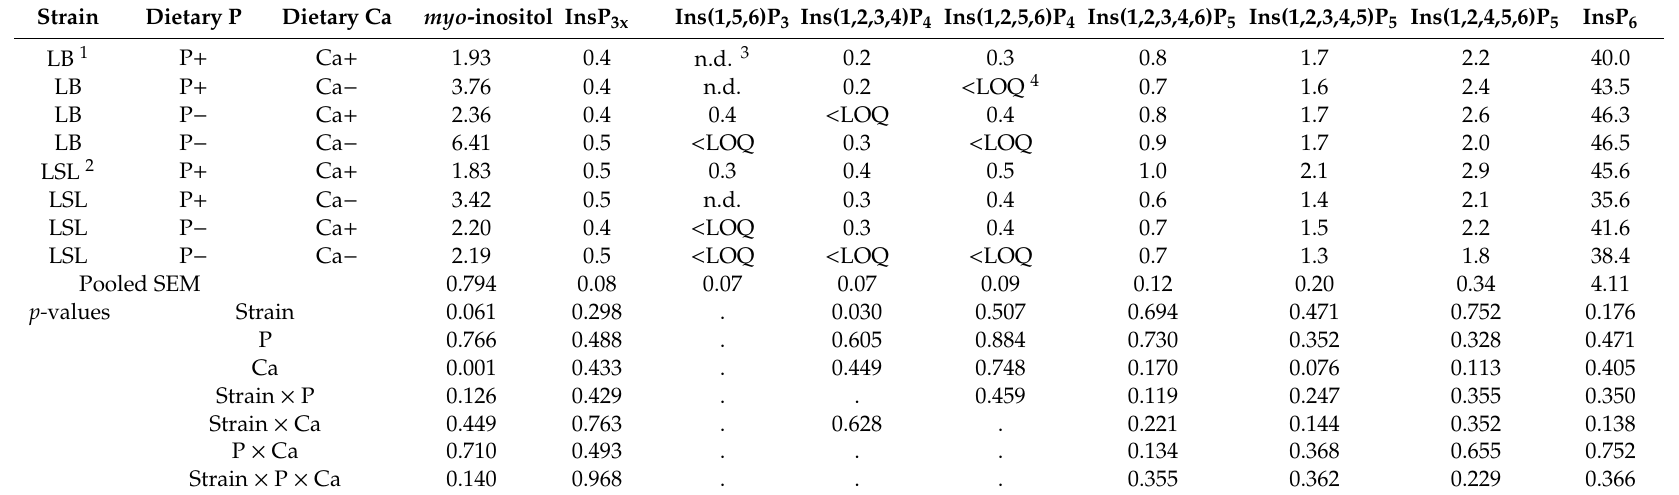
Table 5. E ff ect of strain, P, and Ca on concentrations of myo -inositol and InsP isomers in the ileum of laying hens aged 31 weeks ( µ mol / g). Strain Dietary P Dietary Ca